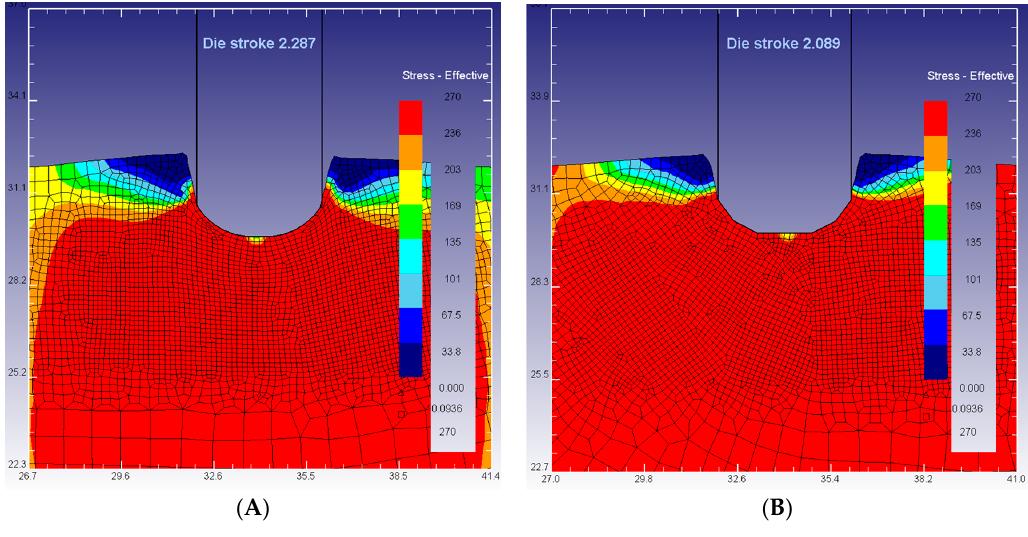
Figure 15. Curve punch approximation with three ( A ) and six ( B ) facets.